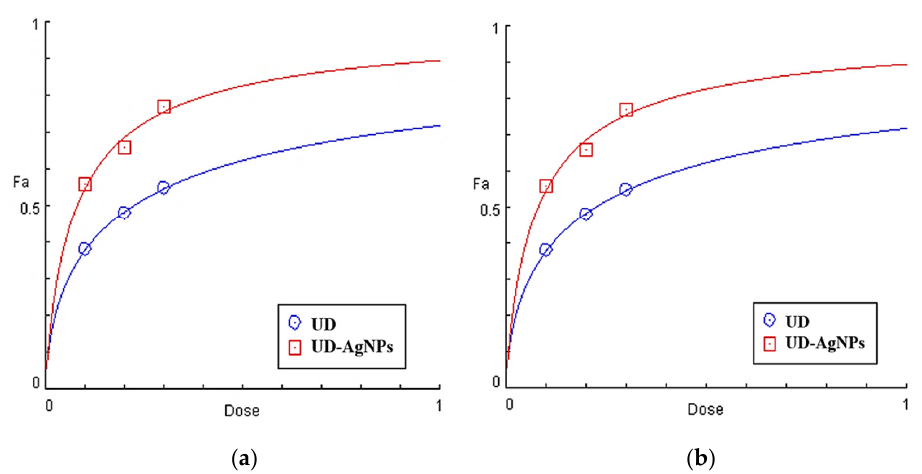
Figure 2. Dose‒response profiles of the calculated EC 50 (mg/mL) of Urtica dioica (UD) and biosynthesized nanoparticles of UD (UD-AgNPs) in the DPPH ( a ) and ABTS ( b )-free radical scavenging tests. Table 2. Using DPPH and ABTS assays, various models were used to estimate the predicted EC 50 (mg/mL) of UD and UD-AgNPs.